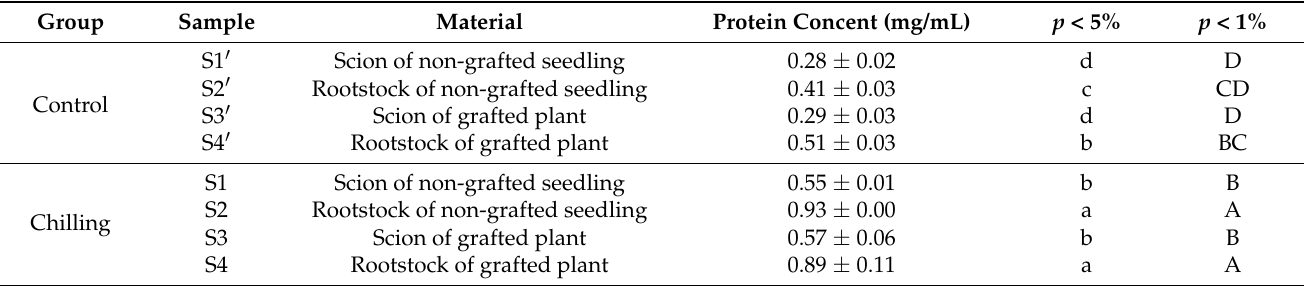
Table 5. Changes induced by chilling stress and grafting in cotton proteins.